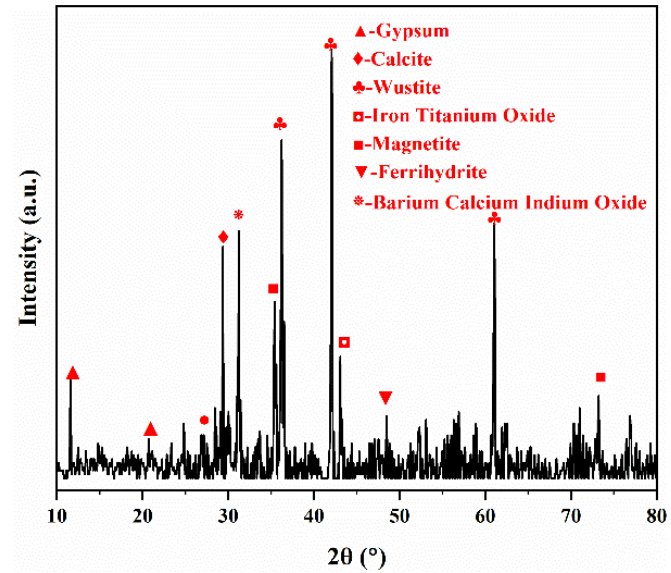
Figure 1. The XRD pattern of the lead slag.